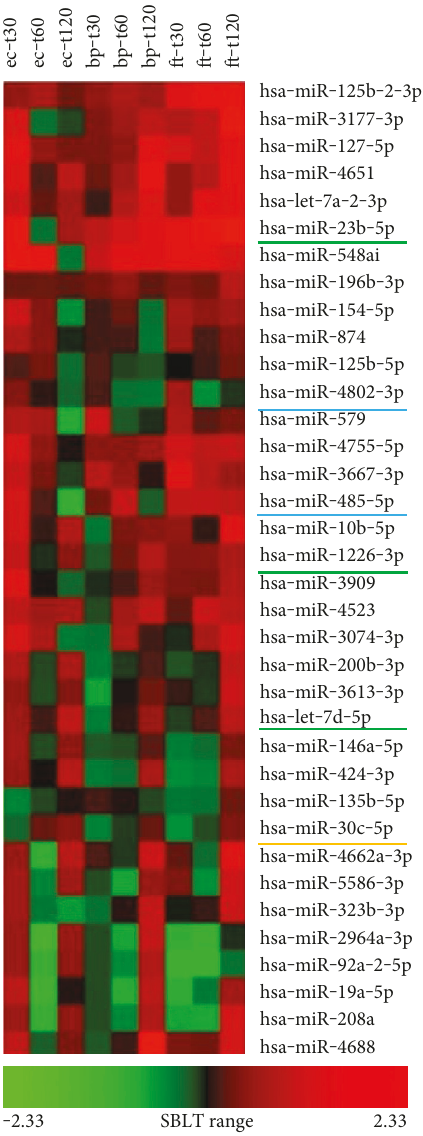
Figure 2: Heatmap of 36 miRNA species tested in the miScript qPCR assay. The qPCR fold changes were plotted for three time points (t30, t60, and t120) for E. coli - (ec-), B. pseudomallei - (bp-), and F. tularensis - (ft-) exposed hPBMCs. The miRNA species that show either decreasing or increasing expression with statistical signi fi cance ( P < 0 05 ) are as follows: in E. coli -exposed hPBMCs, hsa-miR-485-5p and hsa-miR-4802-3p were downregulated (underlined blue); in B. pseudomallei -exposed hPBMCs, hsa-let- 7d-5p, hsa-miR-1226-3p, and hsa-miR-23b-5p were upregulated (underlined green); in both B. pseudomallei - and F. tularensis - exposed hPBMCs, hsa-miR-30c-5p displayed upregulation (underlined